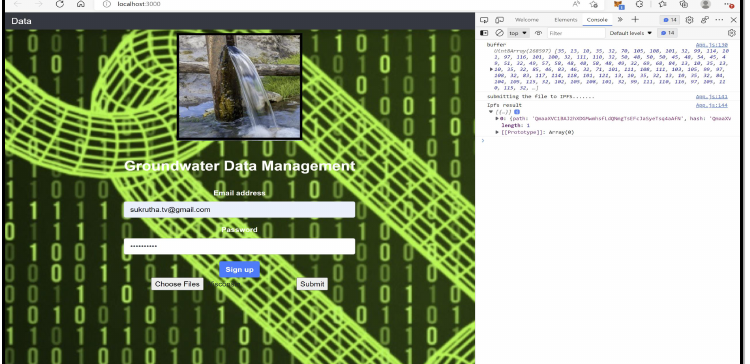
Figure 9. File to buffer to